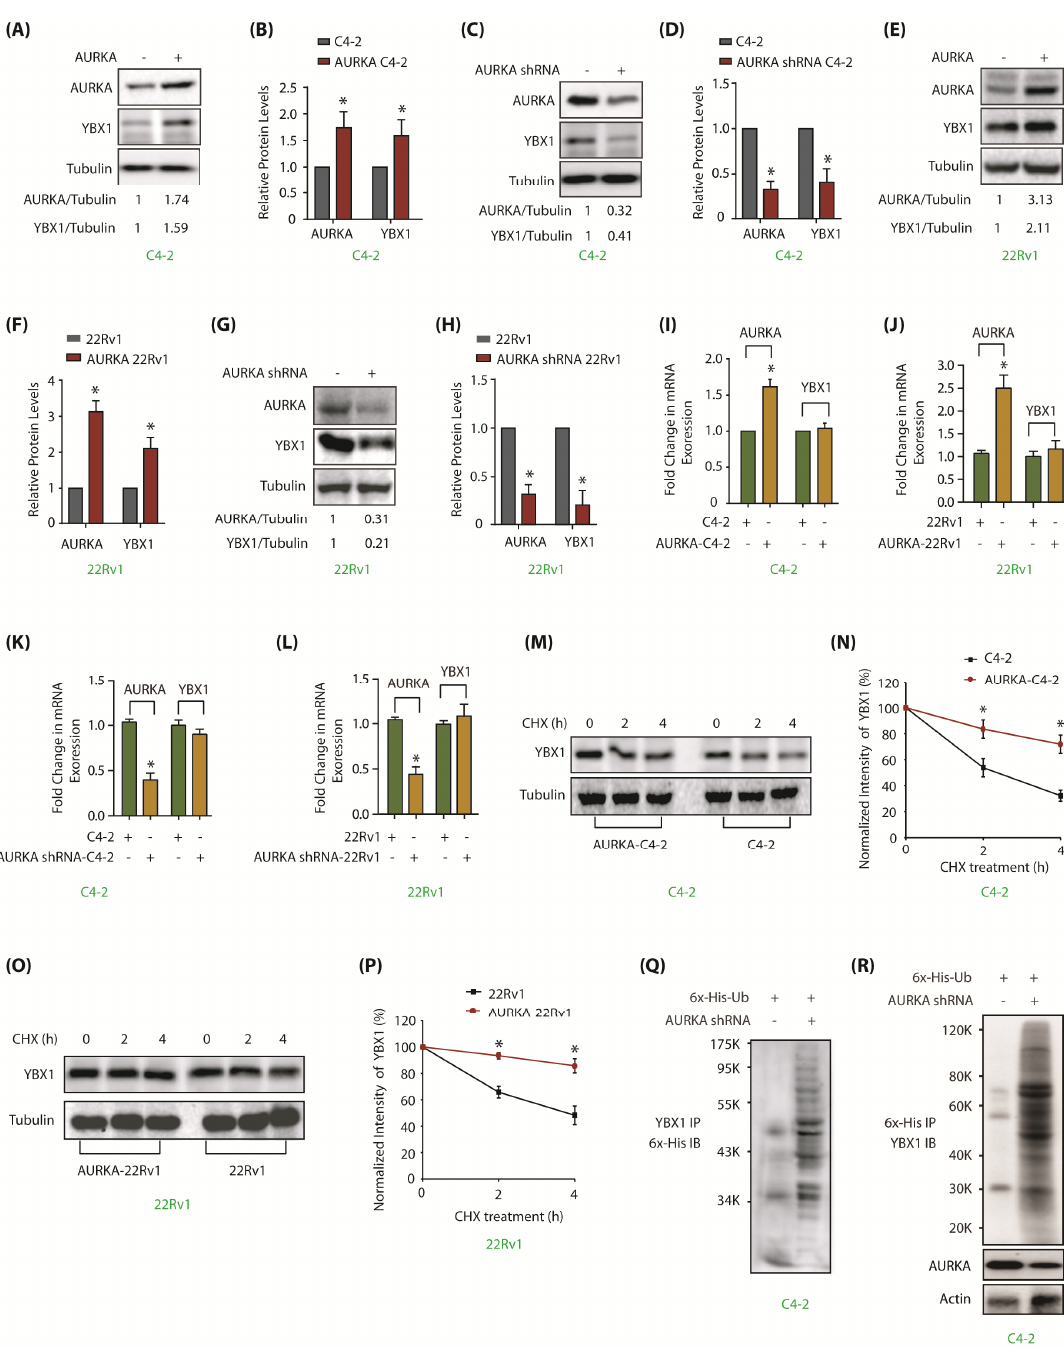
Figure 2. AURKA upregulates YBX1 levels by inhibiting its ubiquitylation in C4-2 and 22Rv1 cells. ( A ) Overexpression of AURKA increases YBX1 levels in C4-2 cells. ( B ) The data represents mean ± SEM of three independent experiments in C4-2 cells. * signifies significance at p < 0.05 compared to control. ( C ) AURKA ablation using AURKA shRNA depletes YBX1. C4-2 cells were exposed to control